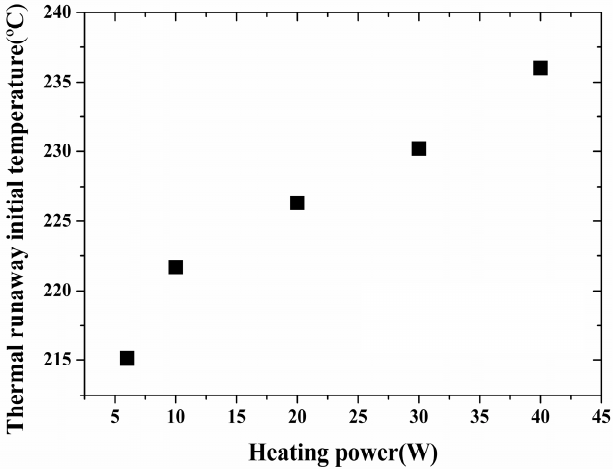
Figure 3. Relationship between constant heating power and thermal runaway initial